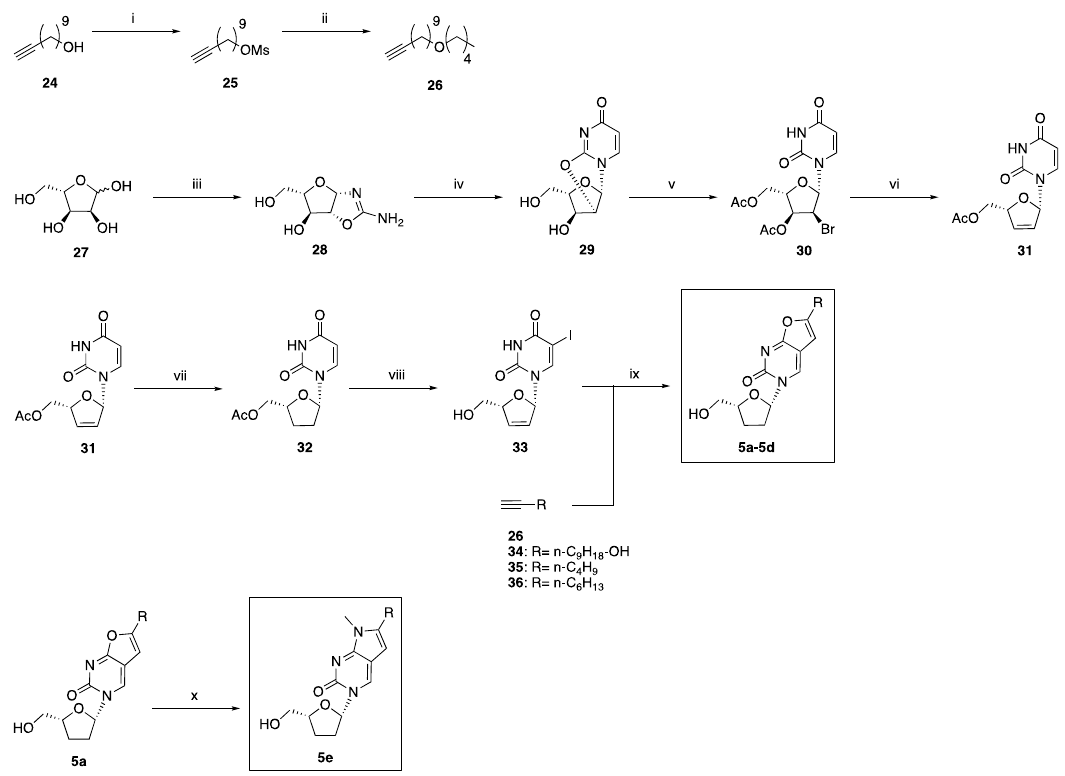
Scheme 2. Preparation of nucleoside analogues 5a – 5e . Reagents and conditions: (i) MsCl, Et3N,